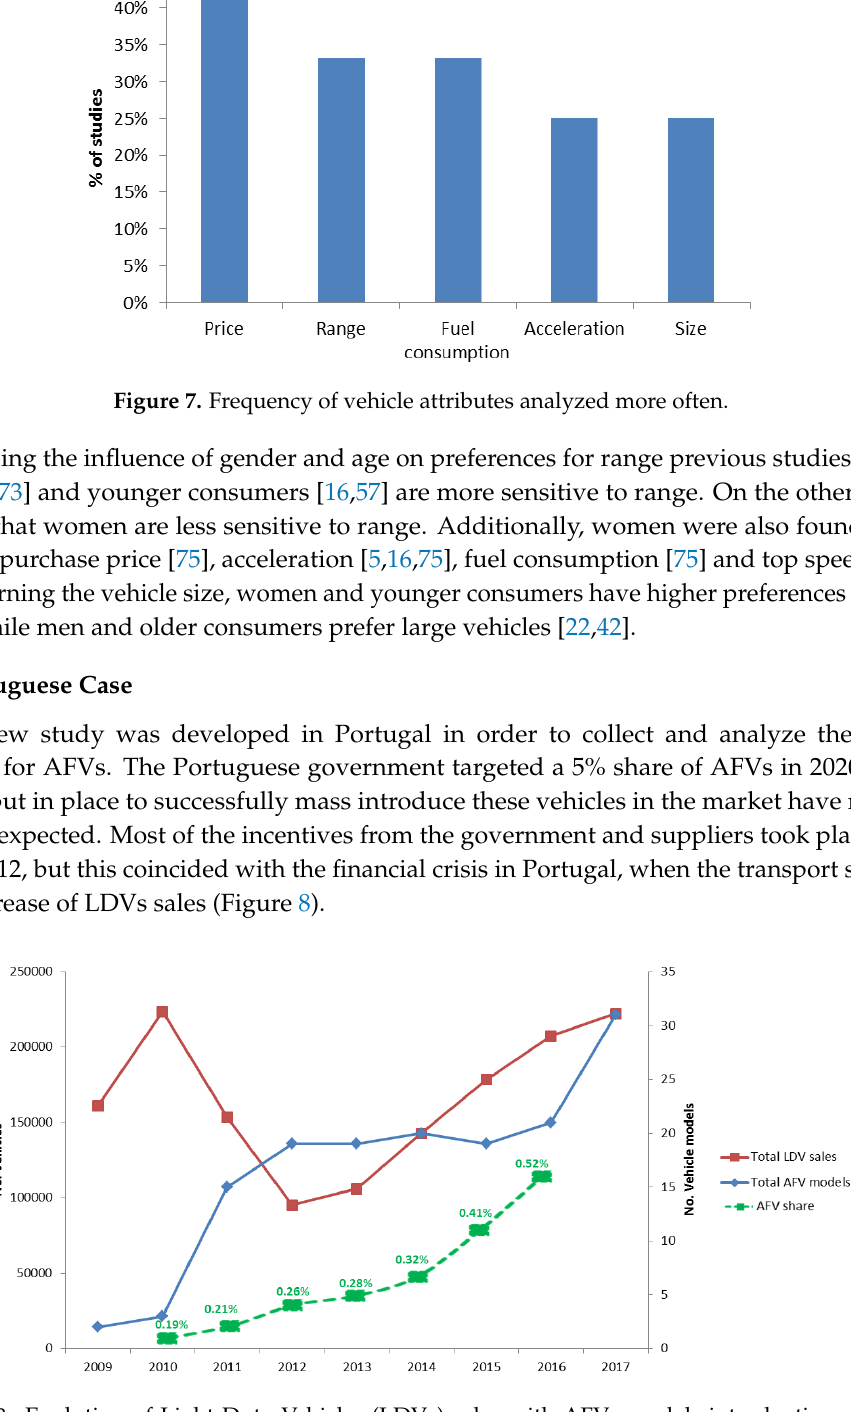
Figure 9. Sales of plug-in electric vehicles crossed with Portuguese government incentives for electric mobility (IUC = circulation tax; ISV = vehicle purchase tax). This context of AFVs market dynamics in Portugal along with the absence of studies analyzing the influence of demographics on Portuguese consumer preferences brings relevance to develop a study in this market under the scope of the review previously presented, i.e., aiming at analyzing Portuguese consumer preferences for AFVs that collected data through a stated preference survey elicited through CM methods. The selection of alternatives in this stated preference survey includes all the main AFVs currently available in the Portuguese market, namely BEVs, PHEVs and HEVs. For comparison purposes two ICEVs vehicles were also included, namely Diesel and Gasoline vehicles. Regarding the attributes